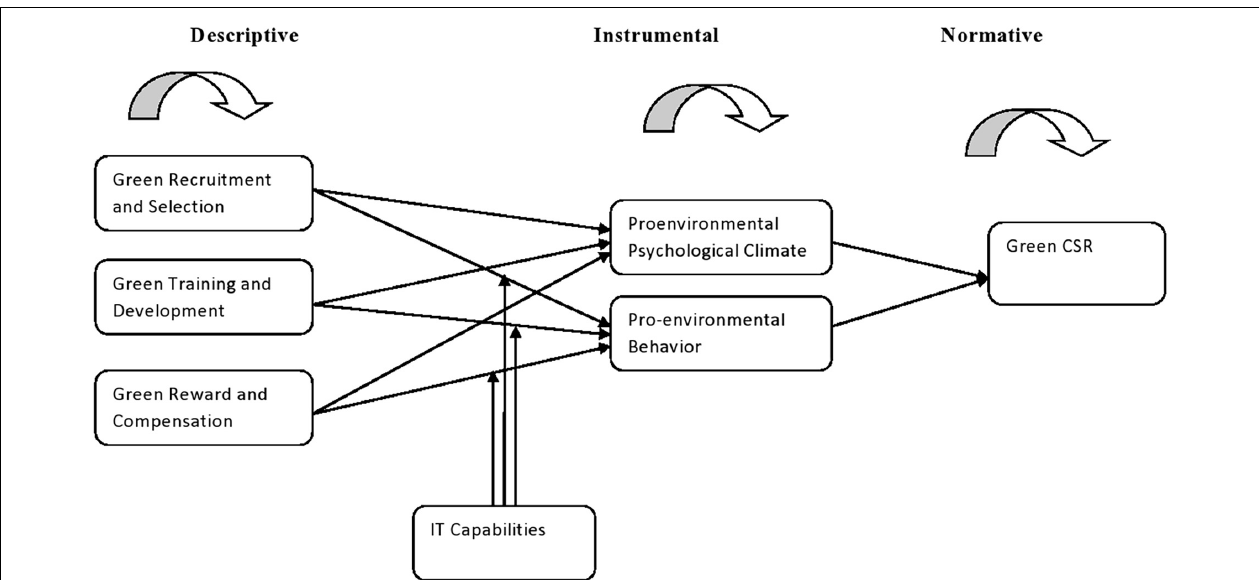
FIGURE 1 | The descriptive, instrumental, and normative perspective of the stakeholder